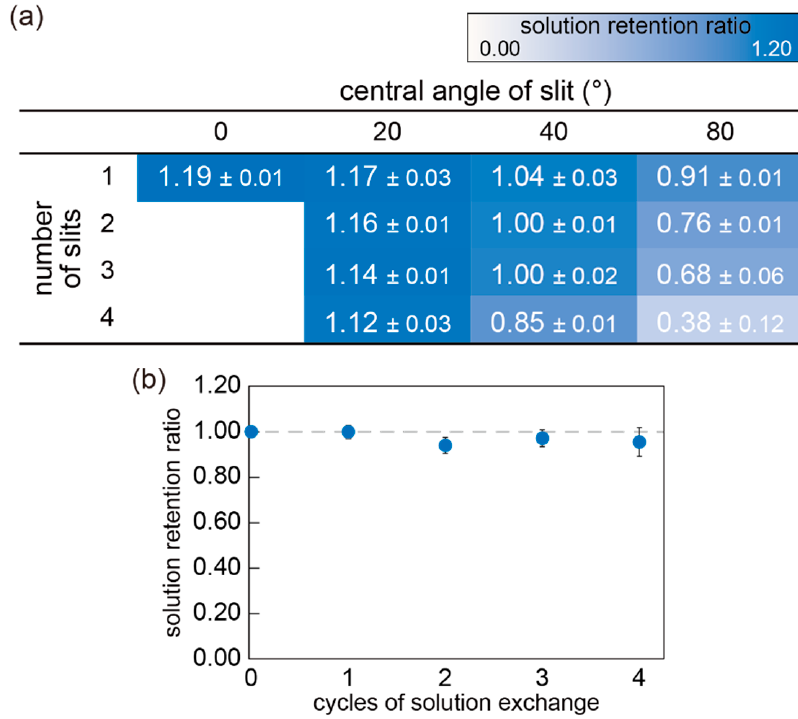
Figure 6. ( a ) Mass ratio of the solution held in mini-cup wells with different central angle and number of slits. The ratios were estimated from the mass change of the solution before and after the solution exchange (N = 3, mean ± standard deviation (SD)), respectively. ( b ) Retention ability over repetitive solution exchanges with the mini-cup well with 3 slits and 40° angle (N = 3, error bar: SD). For both ( a , b ), the solution exchange was performed by fusing the solution to the external solution for 10 s and in sequence separating them.